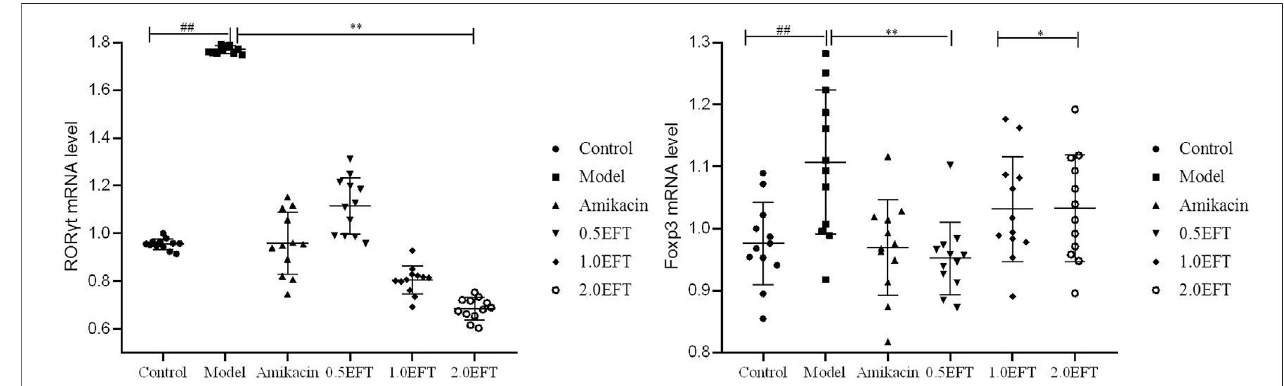
FIGURE8| ThemRNAexpressionlevelsofROR- γ tandFoxp3inlungtissue.Allvaluesareexpressedasmean ± SD( n (cid:2) 12).# p < 0.05;## p < 0.01comparedwith the control group, * p < 0.05; ** p < 0.01 compared with the model